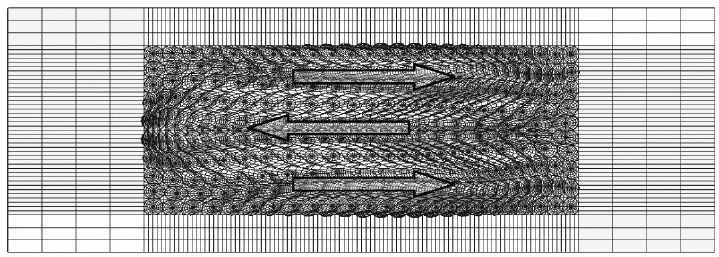
Fig. 48. EIDL 8th mode – 971 Hz – in plane triple opposite horizontal translation.